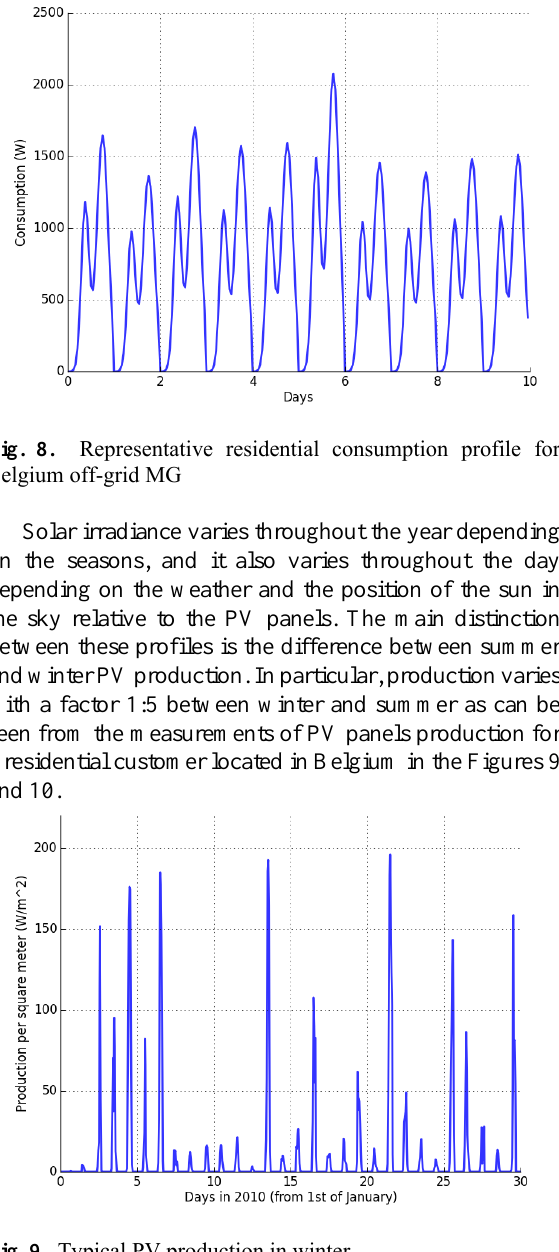
Fig. 9. Typical PV production in